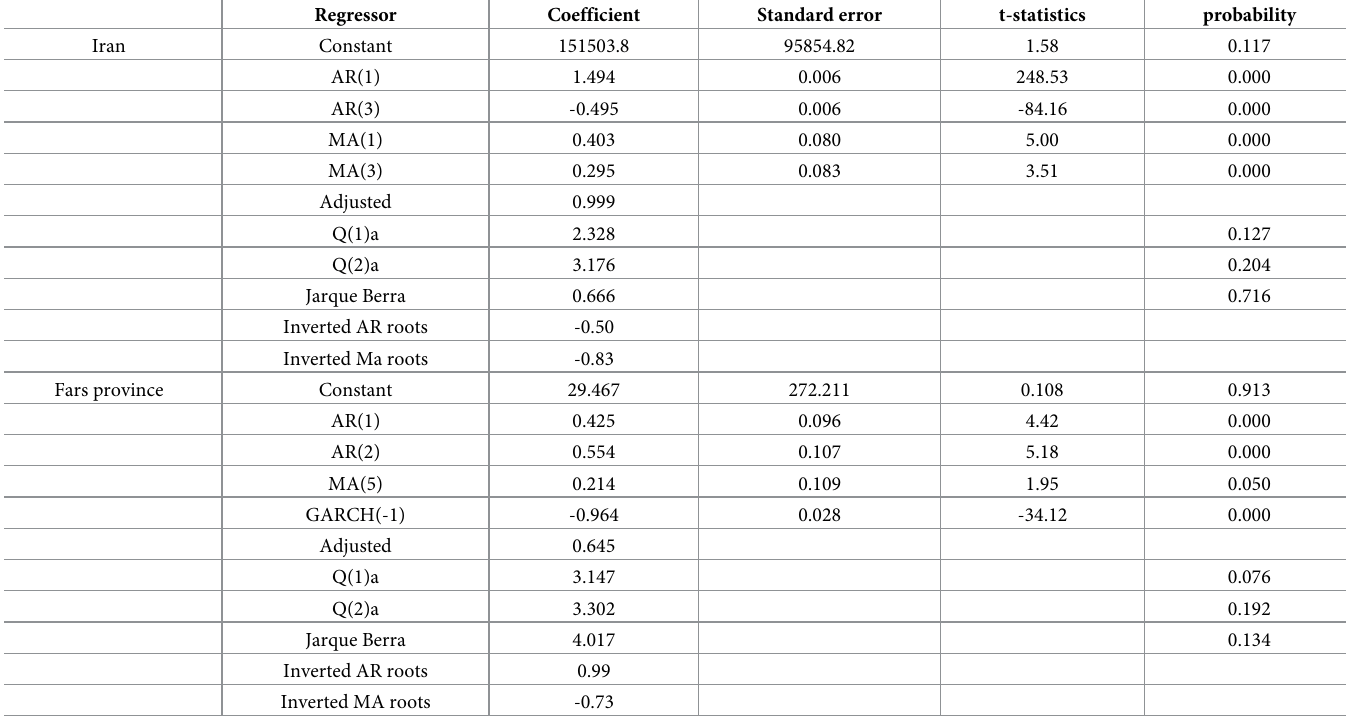
Table 5. The results of autoregressive integrated moving average (ARIMA) model for COVID-19 infection cases of Fars province and